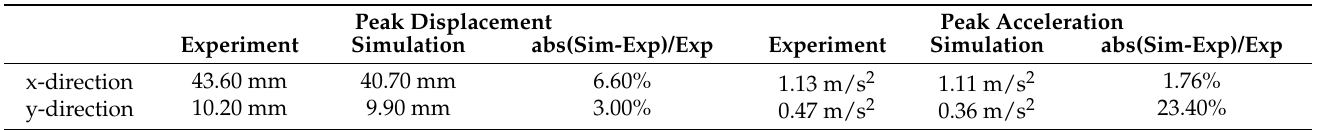
Table 8. Comparisons between experimental and simulated results of the b300d380 bearing under